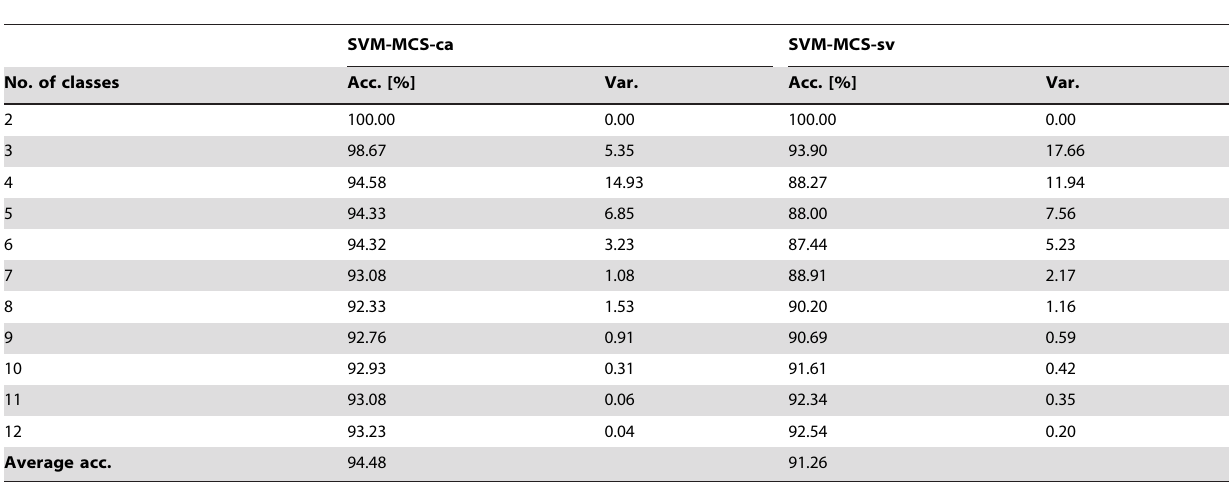
Table 4. Classification accuracy of proposed methods for various number of considered classes.